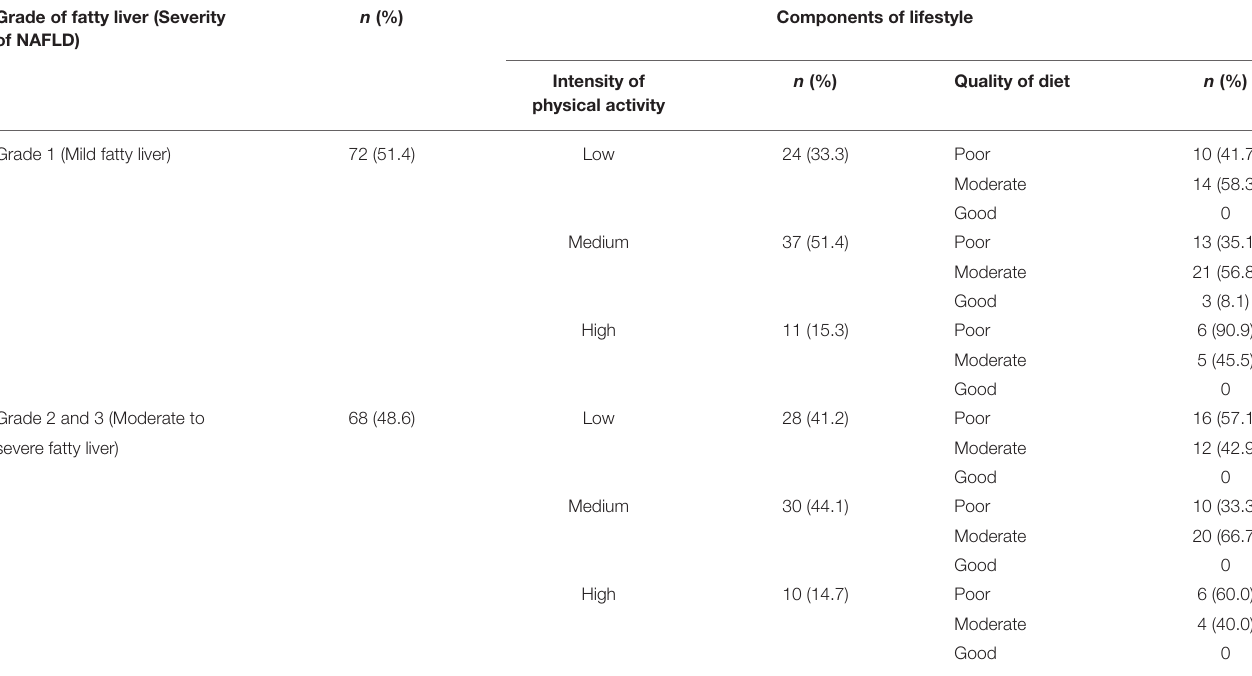
n (%) Components of lifestyle n (%) Quality of diet n (%) Intensity of physical activity